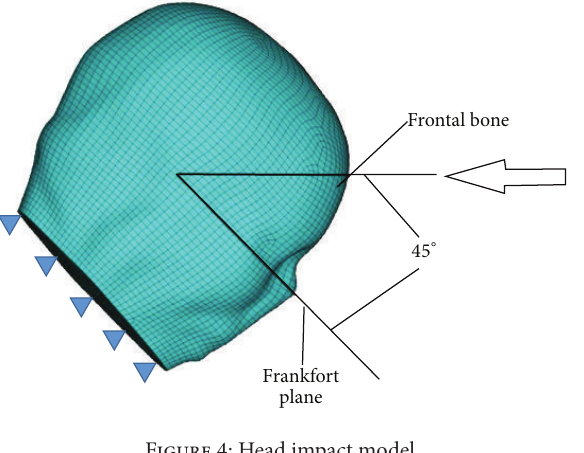
Figure 4: Head impact model.